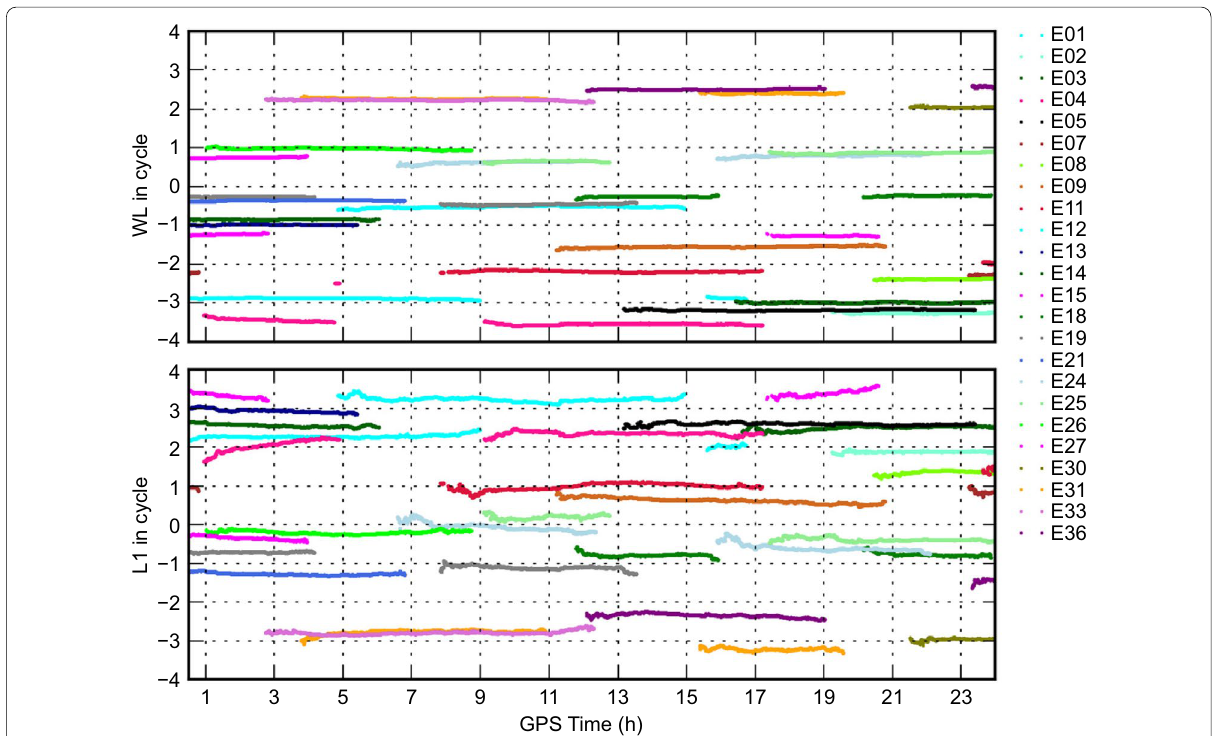
Fig. 5 Time series of hardware WL (top) and L1 biases (bottom) for Galileo